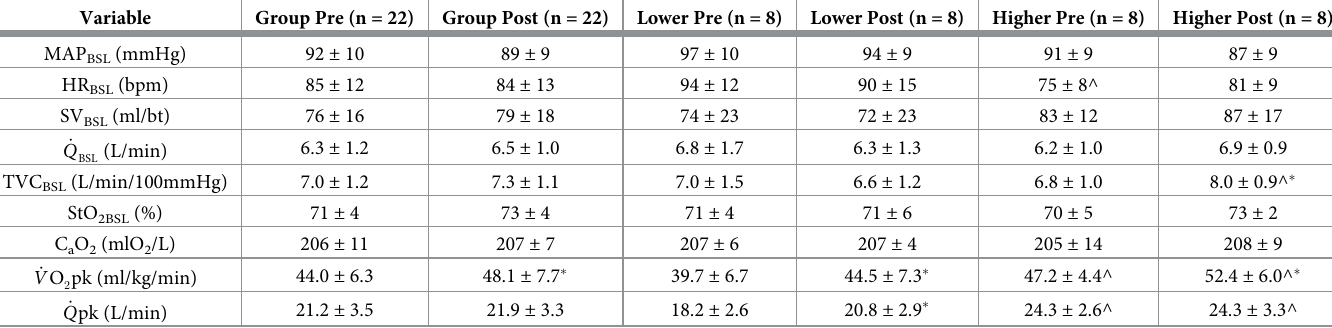
Table 2. Baseline cardiovascular variables and peak